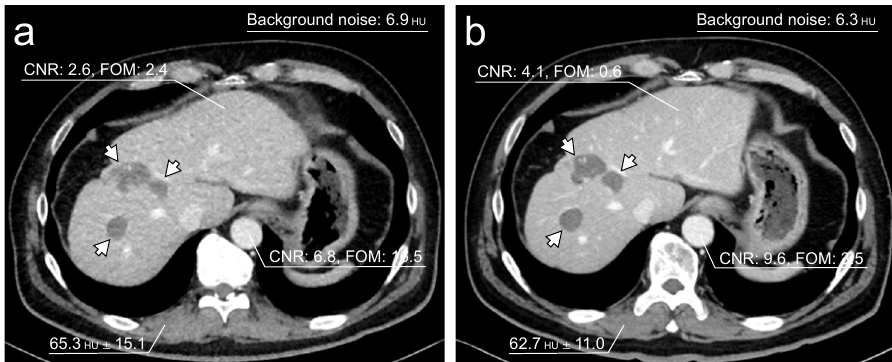
Figure 3. Representative single-phase enhanced CT images. Both images were acquired on separate occasions from a 62-year-old male who had liver metastases after colon cancer surgery. The tin-filtered 100 kV (TF100kV) protocol ( a ) shows lower CNR and higher FOM than the standard 120 kV (ST120kV) protocol ( b ). Liver metastases are detectable in both protocols (arrows).